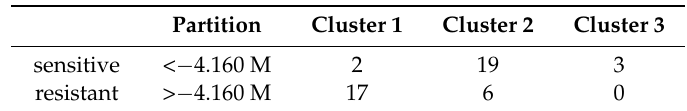
Table 3. Separation of clusters of NCI cell lines obtained by hierarchical cluster analysis shown in Figure 5 in comparison to drug sensitivity.